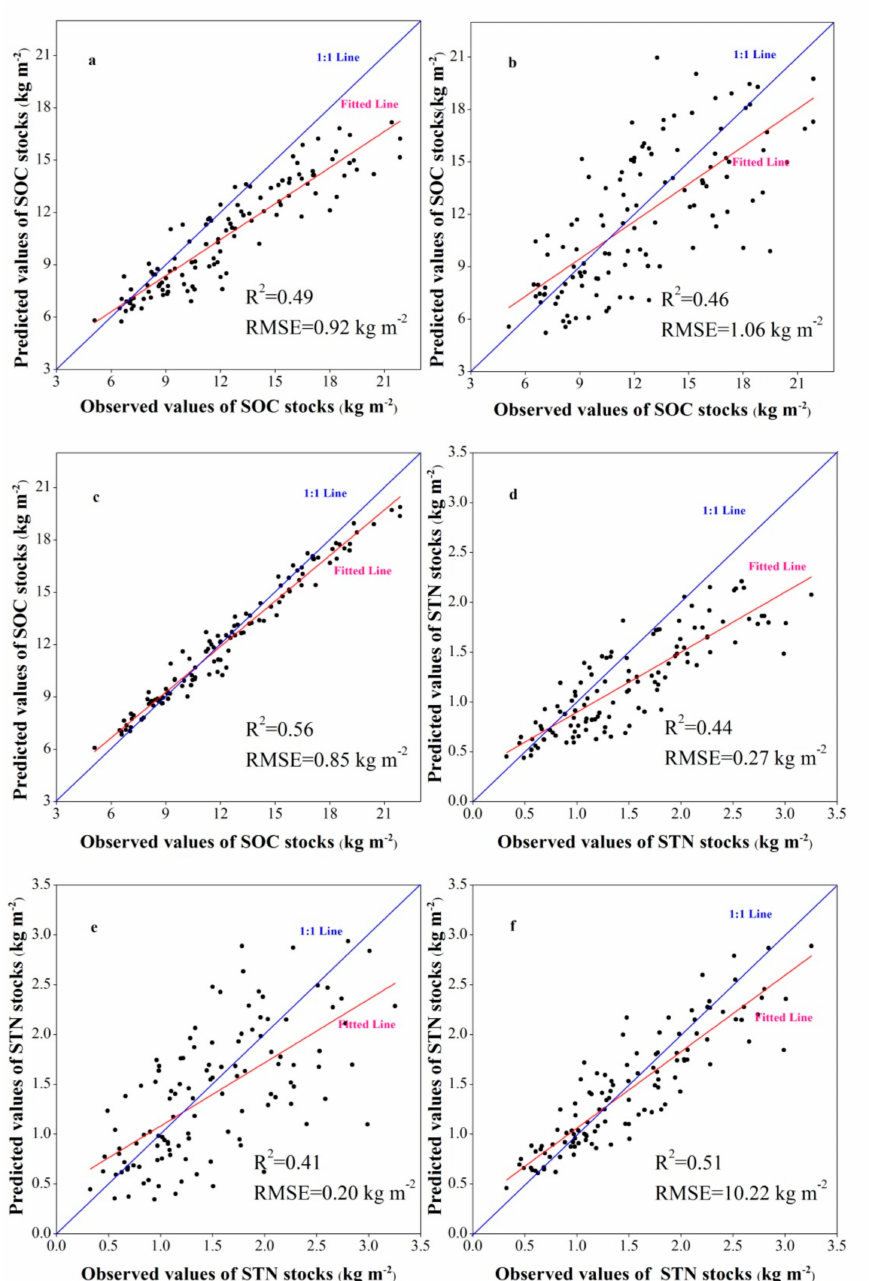
Figure 4. Scatter plot of the predicted and measured topsoil (0–30 cm) soil organic carbon stocks (SOC) (kg m − 2 ) and soil total nitrogen (STN) (kg m − 2 ). The predicted data are derived from geographically weighted regression (GWR) ( a , d ), multiple stepwise linear regression (MSLR) ( b , e ), and boosted regression trees (BRT) ( c , f